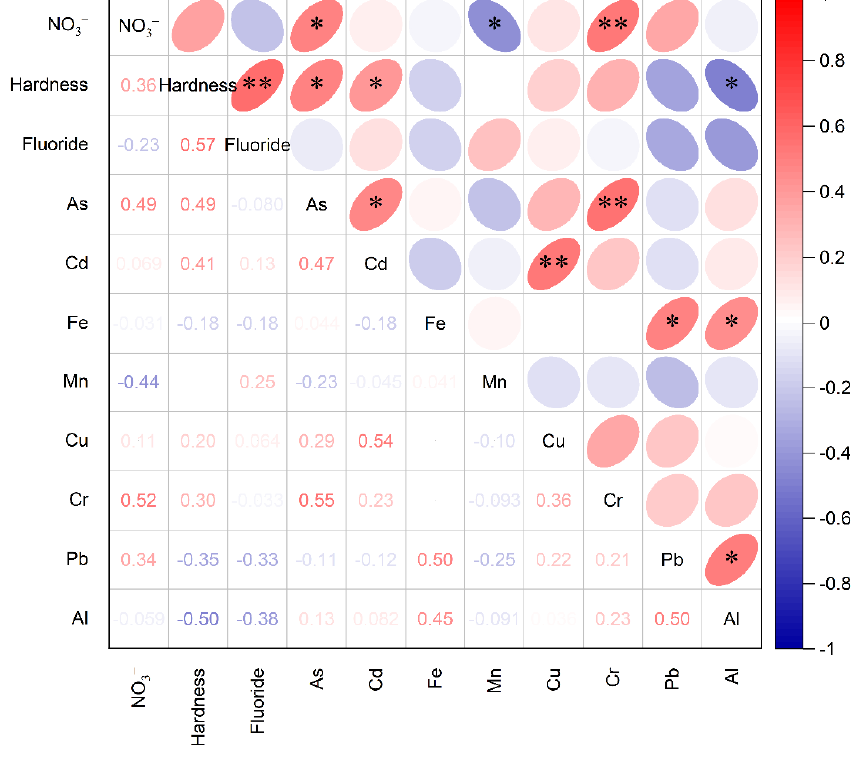
Figure 3. Correlation coefficients for Pearson correlation analysis among groundwater quality parameters. * Correlation is significant at p < 0.05; ** Correlation is significant at p < 0.01.